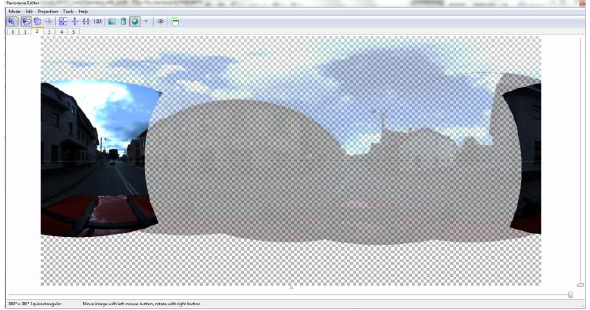
Figure 4. Stitching one of the frames from Ladybug®3 in